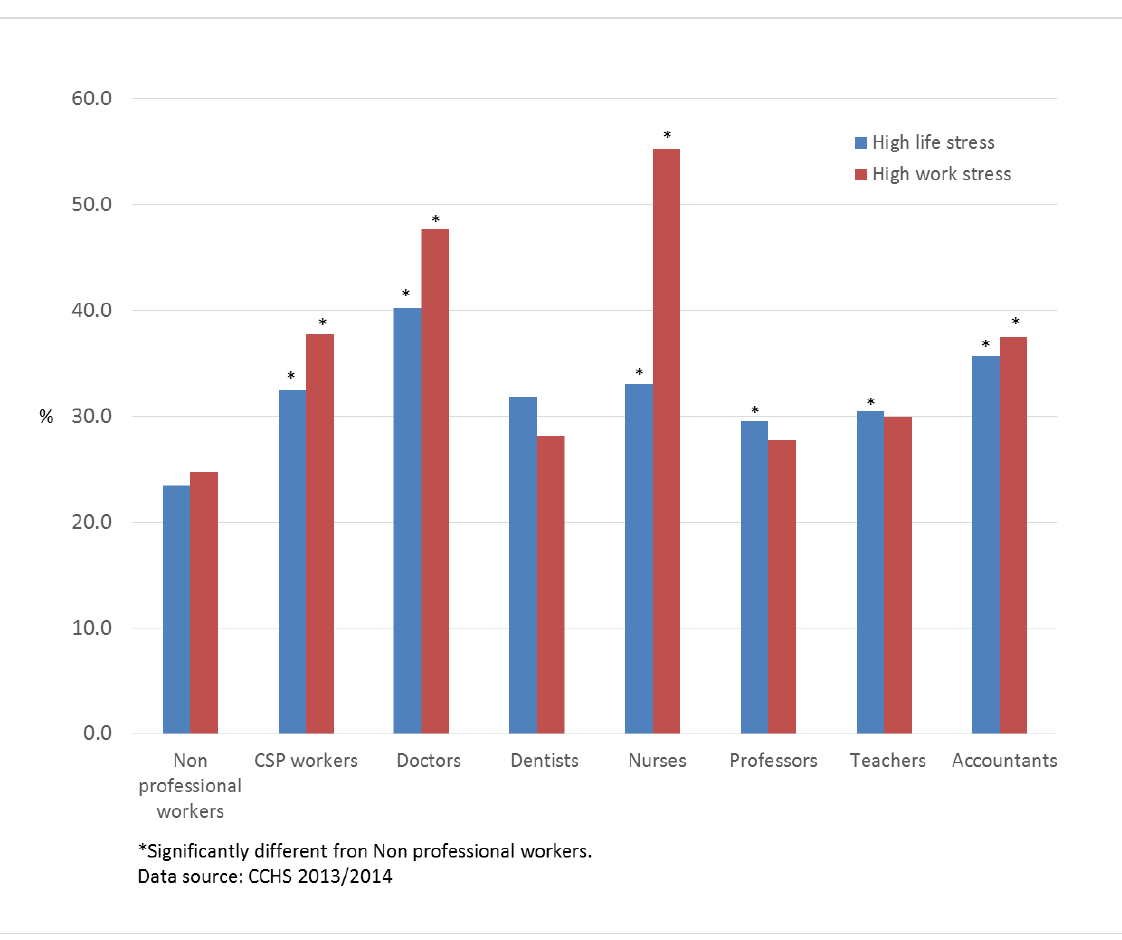
Figure 1. CSP workers reported high (quite a bit or extremely stressful) work and life stress compared to non-professional workers. Nurses reported the highest work stress while professors reported the